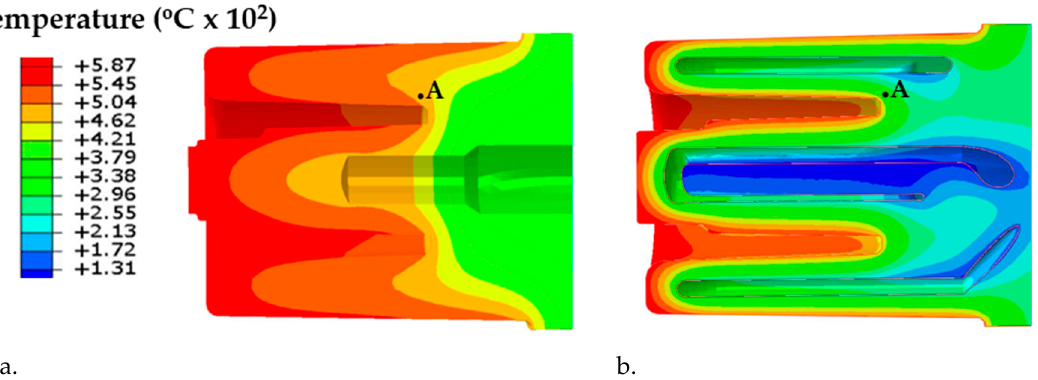
Figure 6. A comparison of temperature field in the cores: ( a ) classical (6.5 s after injection); ( b ) conformal (2.8 s after injection) when the temperature at the point marked ‘A’ reached its highest value during the stabilised core cycle.